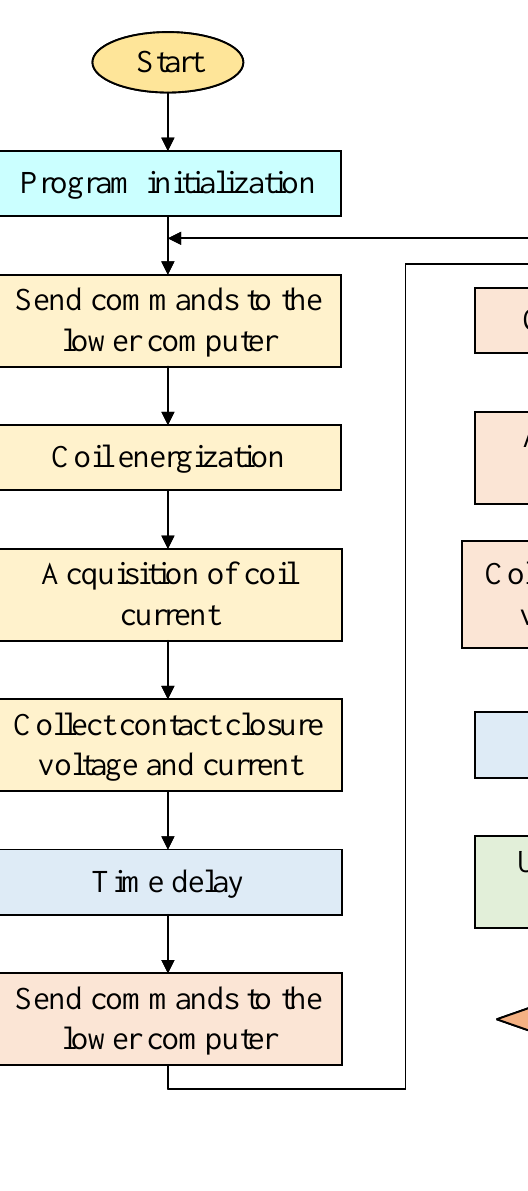
Figure 9. Flow chart of software